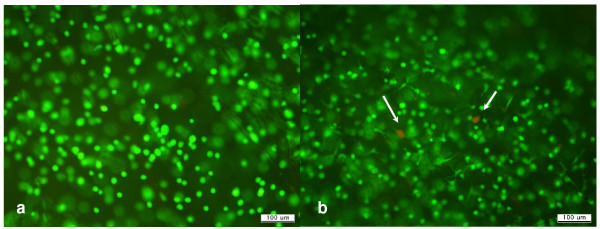
The viable chondrocytes within the cell-gel mixture on Calcein-AM/Ethidium homodimer-1 staining: a) A 0-hour and b) A 72-hour culture (×100). The white arrow in b) denotes the dead cells which appear as a reddish color.